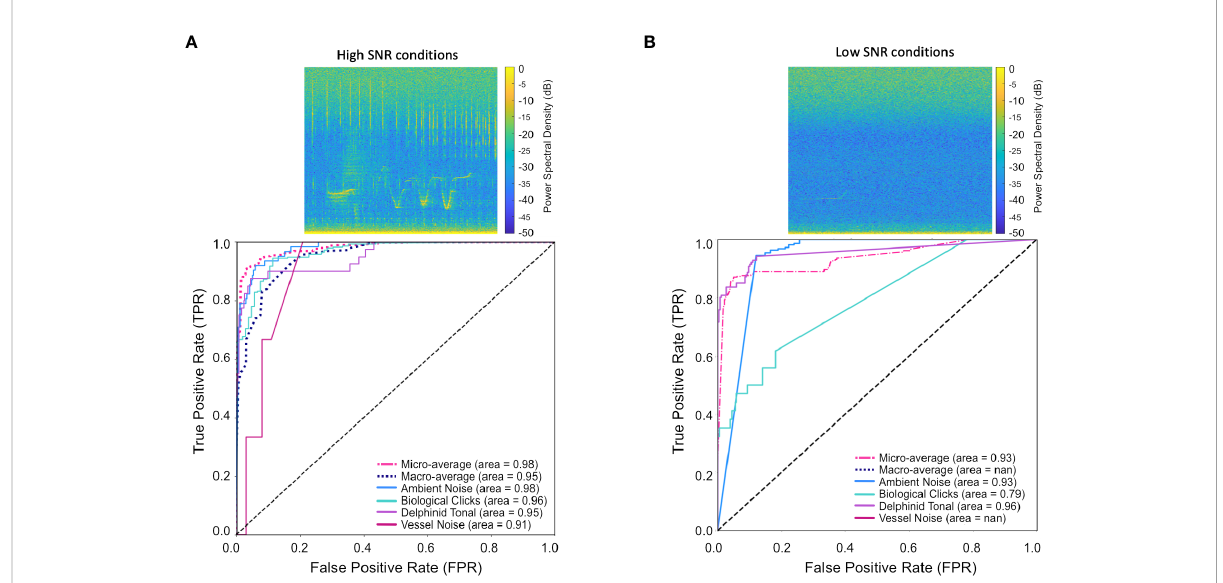
FIGURE 9 Comparison of CNN performance for periods of (A) high, and low (B) signal to noise ratio, represented as receiver operating characteristic (ROC) curves. Our model was able to classify delphinid calls with 80% accuracy in low-quality data, and 95% accuracy in high-quality data. Reduced accuracy occured in the biological click class in low-quality data, AUC = 0.79. Manual analysis determined many missed detections are due to singular higher strength clicks amongst low signal strength clicks. Spectrograms (A, B) were computed using a Hanning window, FFT size 2048 and a 75% overlap.